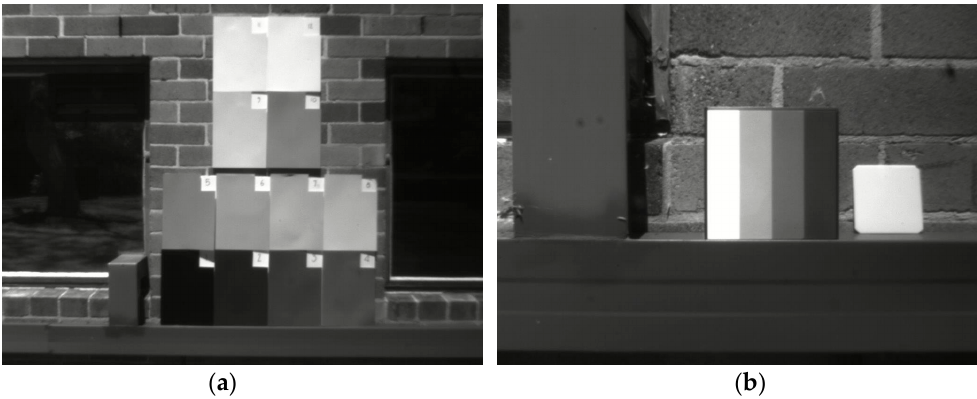
Figure 3. Dulux colour cards ( a ) and Spectralon multi-step calibration target (striped) ( b ).